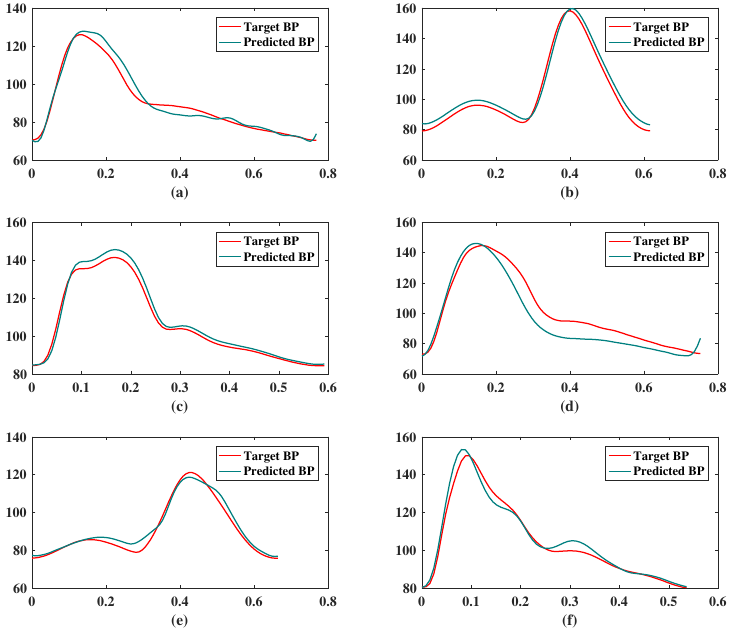
Figure 10. Examples of BP waveform prediction results of the proposed model. These subgraphs are randomly selected targets and predicted BP waveforms of ( a ) segment ID 287, ( b ) segment ID 1199,